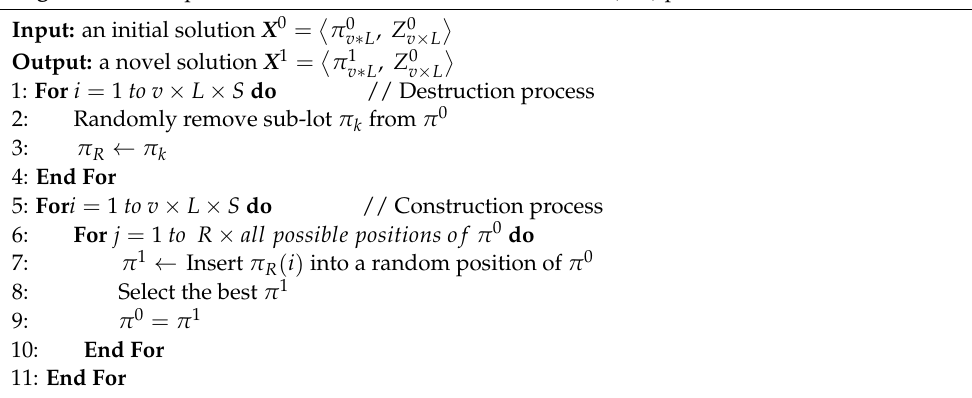
Algorithm 4 The procedure for the destruction-construction (DC)